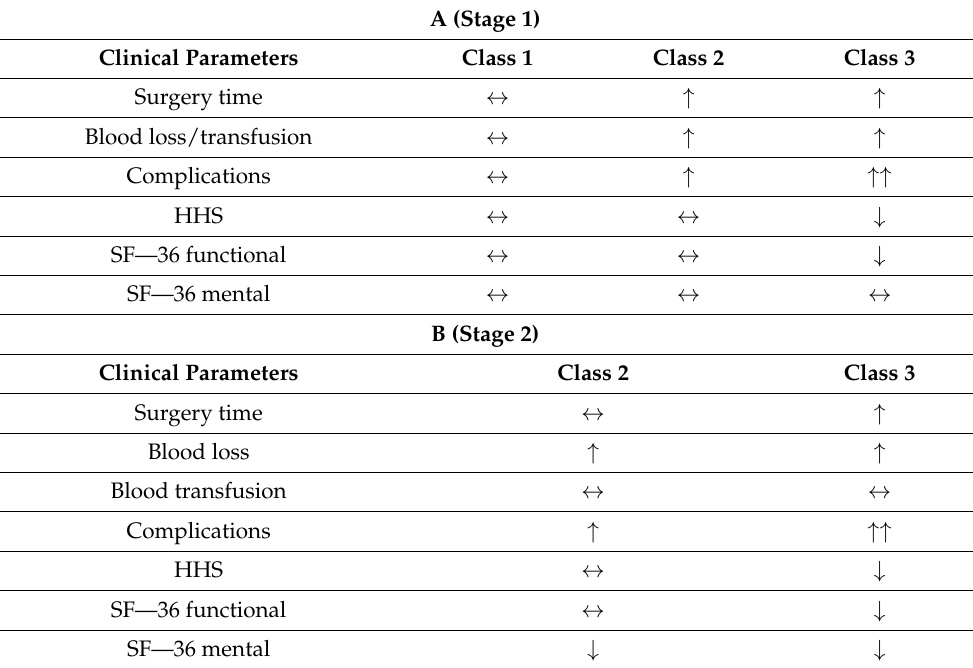
Table 5. Descriptive summary of the comparison of clinical outcome of patients with obesity Class 1, 2, 3 and with normal BMI in the retrospective (Stage 1) study(A) and of patients with obesity Class 2, 3 in comparison to patients with Class 1 obesity in the prospective (Stage 2) study. ↑ —significantly increased. ↓ —significantly decreased. ↔ —no significant